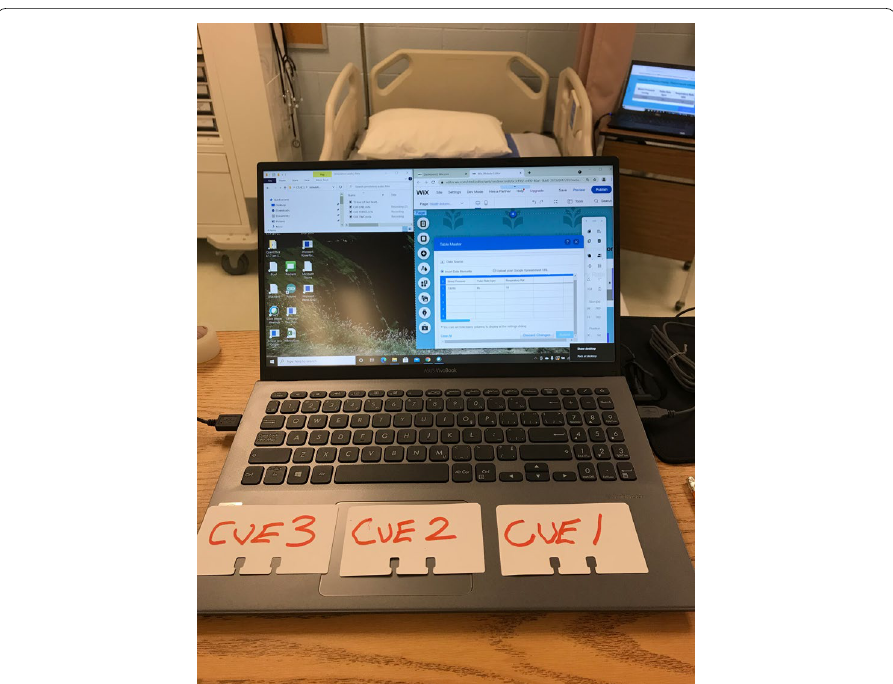
Fig. 4 Simulation control computer showing WIX editor, audio files and manual cue